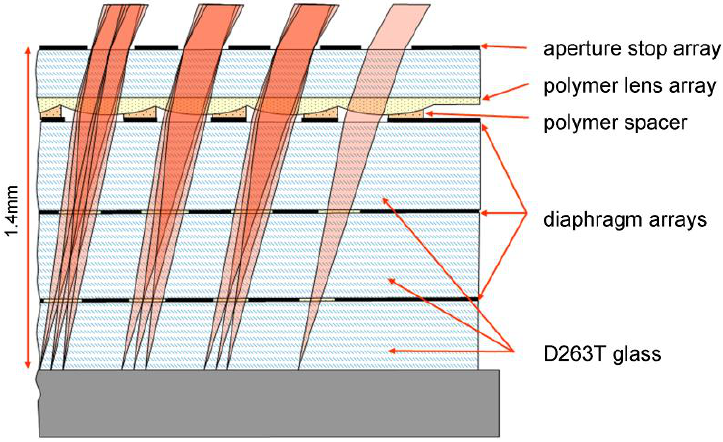
Figure 8. Schematic cross section of a multiaperture imaging system with VGA resolution.